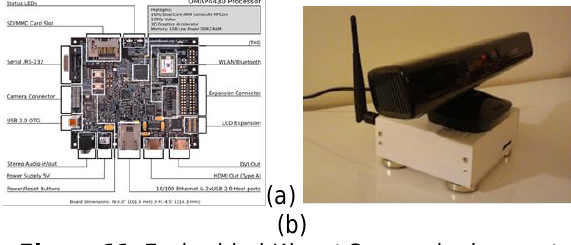
Figure 11. Embedded Kinect Server deployment: Panda board (a) and physical prototype integrated with the MS Kinect for Windows sensor